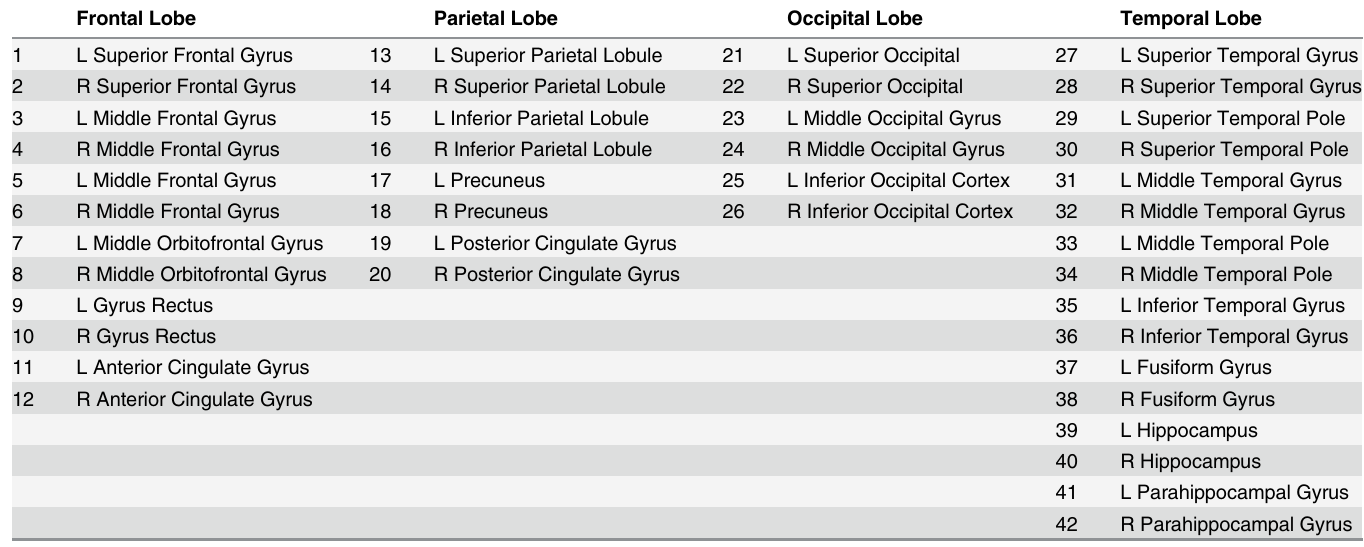
Table 2. Names of the VOIs used in the brain connectivity learning